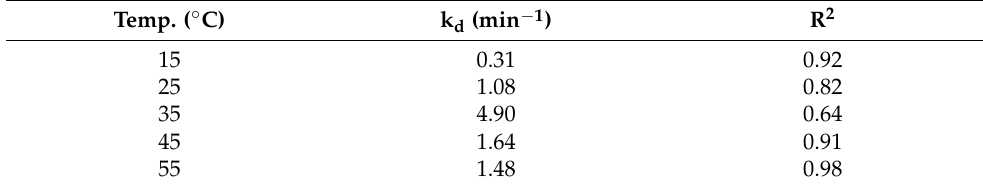
Table 7. Parameters of the external solid diffusion model calculated at different